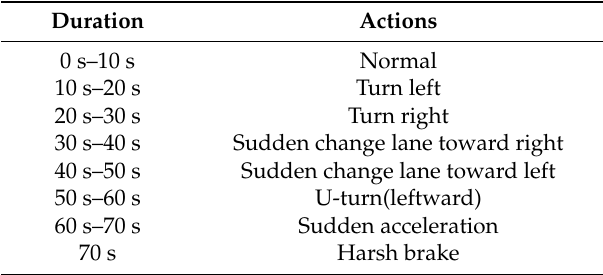
Table 1. Driving pattern for data collection to calculate the